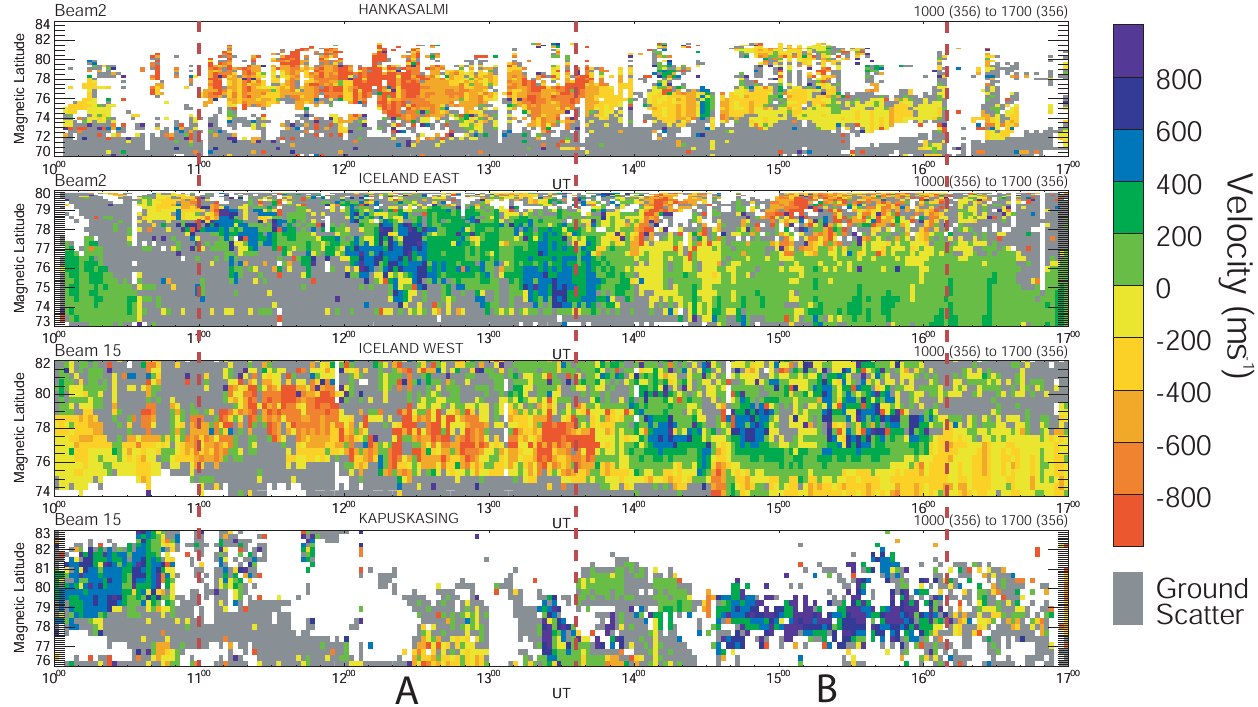
Fig. 3. The l-o-s velocities from the Hankasalmi (beam 2), Iceland East (beam 2), Iceland West (beam 15) and Kapuskasing (beam 15) radars, from 10:00 to 17:00 UT on 22 December 2002. The plots presents l-o-s velocity as a function of time, the velocity is colour coded where positive values (green and blue) show flows toward the radar and negative values (yellow and red) show flows away from the radar. Time intervals A and B are indicated on the plot by the vertical dashed lines.